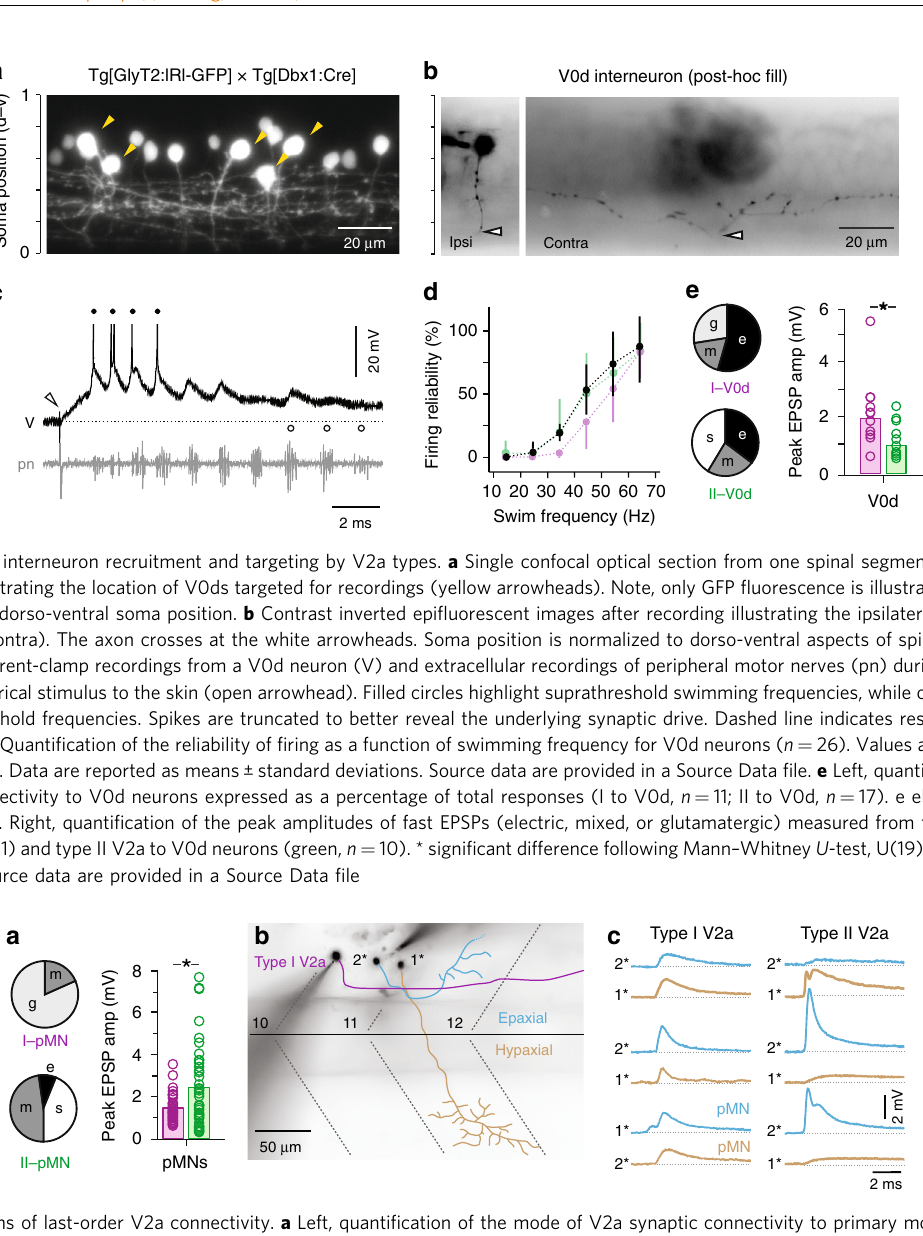
Fig. 6 Distinct patterns of last-order V2a connectivity. a Left, quanti fi cation of the mode of V2a synaptic connectivity to primary motor neurons (pMN) expressed as a percentage of total responses (I to pMN, n = 38; II to pMN, n = 71). e electric, m mixed, g glutamatergic, s slow. Right, quanti fi cation of the peak amplitudes of fast EPSPs (electric, mixed, and glutamatergic) measured from type I V2a to primary motor neurons (purple, n = 38) and type II V2a to primary motor neurons (green, n = 40). * signi fi cant difference following Mann – Whitney U -test, U(76) = 580, p < 0.05). Bars represent means. Source data are provided in a Source Data fi le. b Contrast inverted fl uorescent images of fi lls post-recording from a type I V2a neuron (purple) and an epaxial (blue) and hypaxial (brown) primary motor neuron. 1*, targeted fi rst; 2*, targeted second. Segment boundaries and the horizontal myoseptum are marked by black dashed lines. Body segments are numbered. c Average excitatory post-synaptic potentials recorded from hypaxial primary motor neurons (brown) and epaxial motor neurons (blue) for type I V2a neurons (left) and type II V2a neurons (right). Each row represents a different experiment ( n = 3 for each). Order of post-synaptic recording is indicated by 1* ( fi rst) and 2*